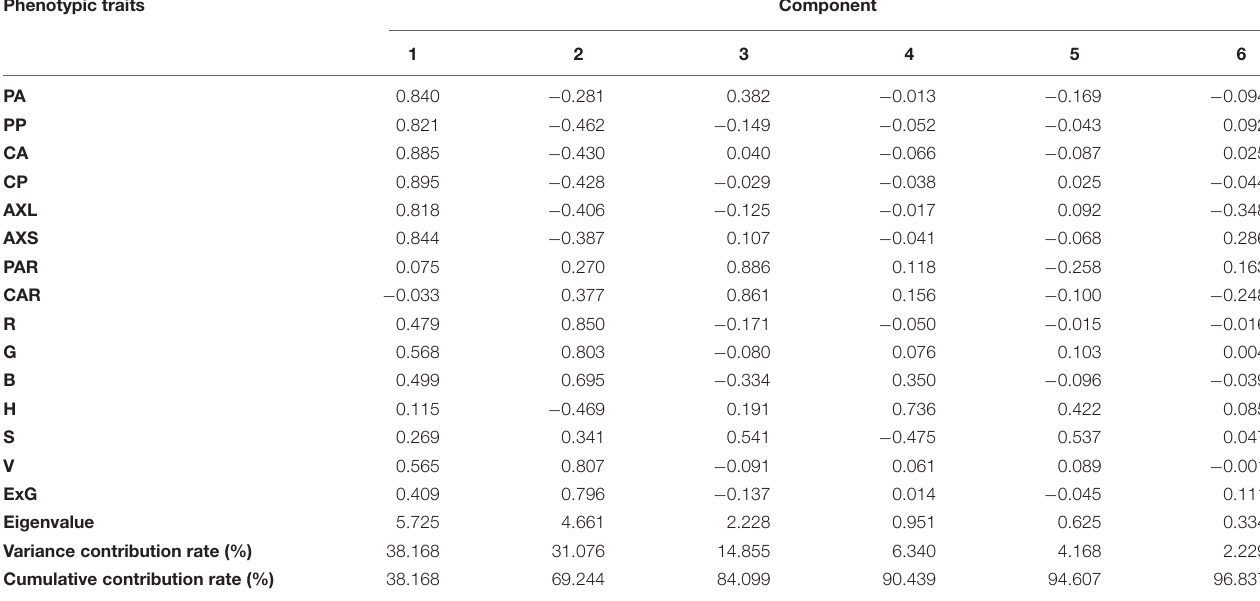
TABLE 4 | Principal component analysis of lettuce